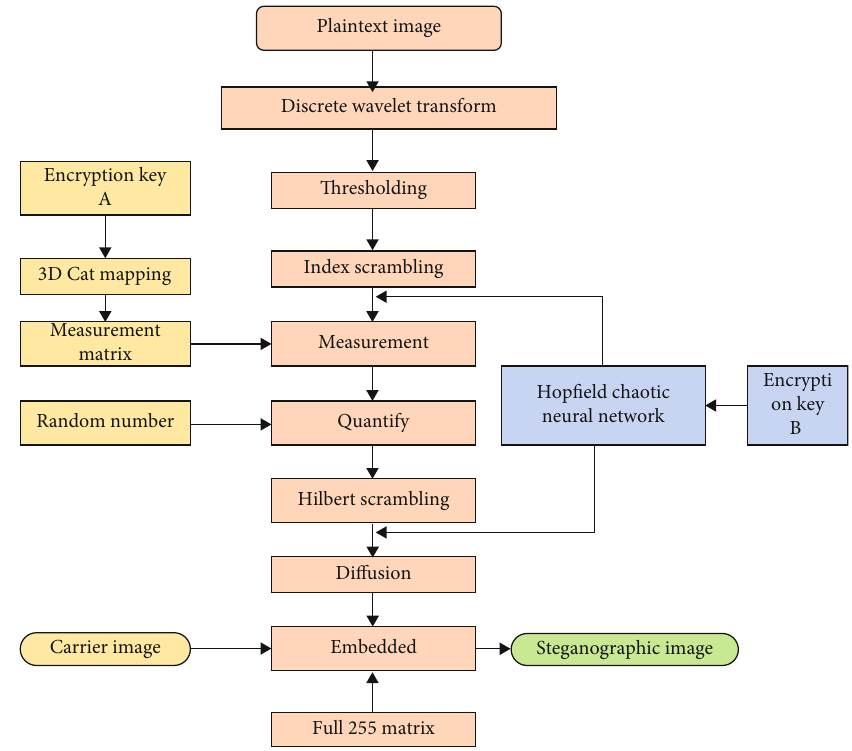
Figure 1: The proposed encryption algorithm fl